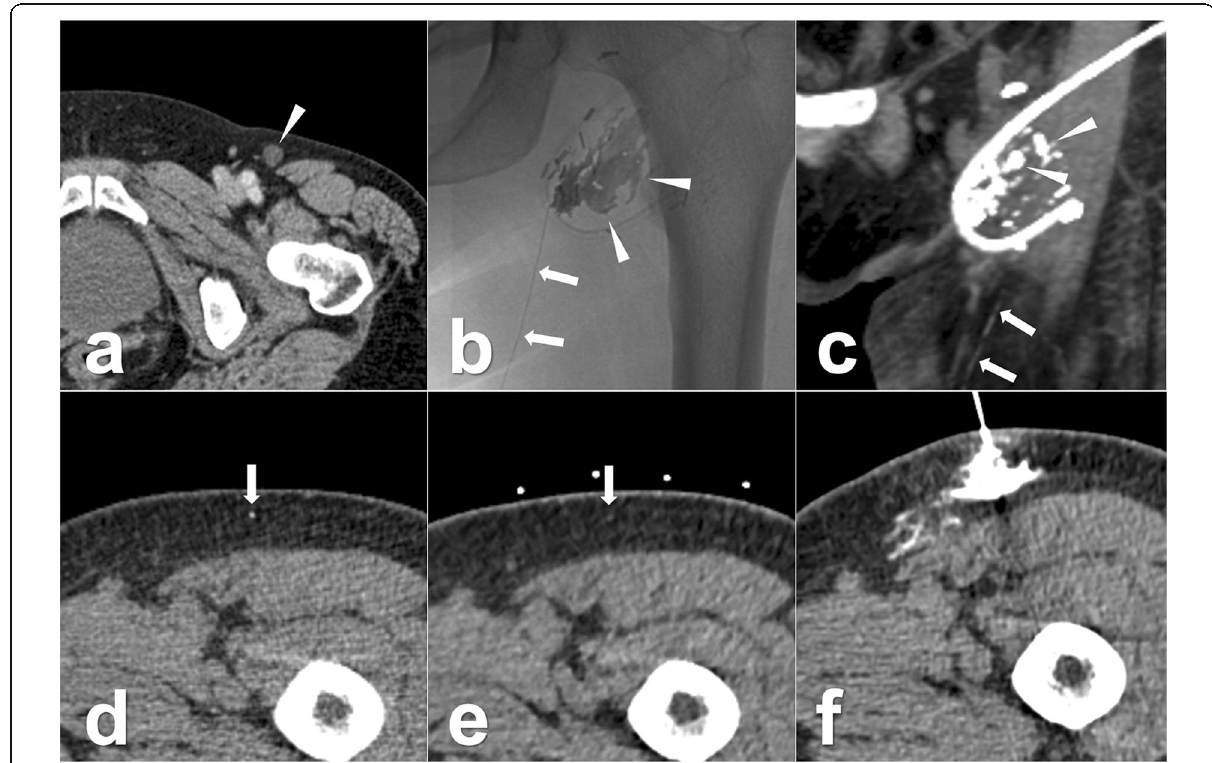
Fig. 4 Images from a patient who underwent a melanoma resection on the left leg 4 months before. a A suspicious relapse of one left inguinal lymph node (white arrowhead). Then, a left inguinal lymphadenectomy was performed, and the pathological result confirmed the lymph node metastasis. After this surgery, the continuous LL was observed with an average output of 100 mL/day. Owing to the ineffective surgical revision, the TL was performed and definite iodinated oil extravasation (white arrowheads) from one lymphatic vessel (white arrows) was found using both fluoroscopy ( b ) and a sequential CT scan, obtaining coronal ( c ) and axial ( d ) reconstructions. Ten days after TL, percutaneous ALVS was performed due to there being no regression of the drainage. e In the preoperative CT scan, the afferent lymphatic vessel (white arrowhead) could still be identified. f Afterwards, a successful puncture was achieved, and 1 mL of contrast fluid was injected that showed an ideal distribution around the target lymphatic vessel. Then, 1.0 mL 95% ethanol was injected. One day later, the leakage ceased completely, and the drainage was removed. The patient was discharged on the same day. ALVS Afferent lymphatic vessel sclerotherapy, CT Computed tomography,